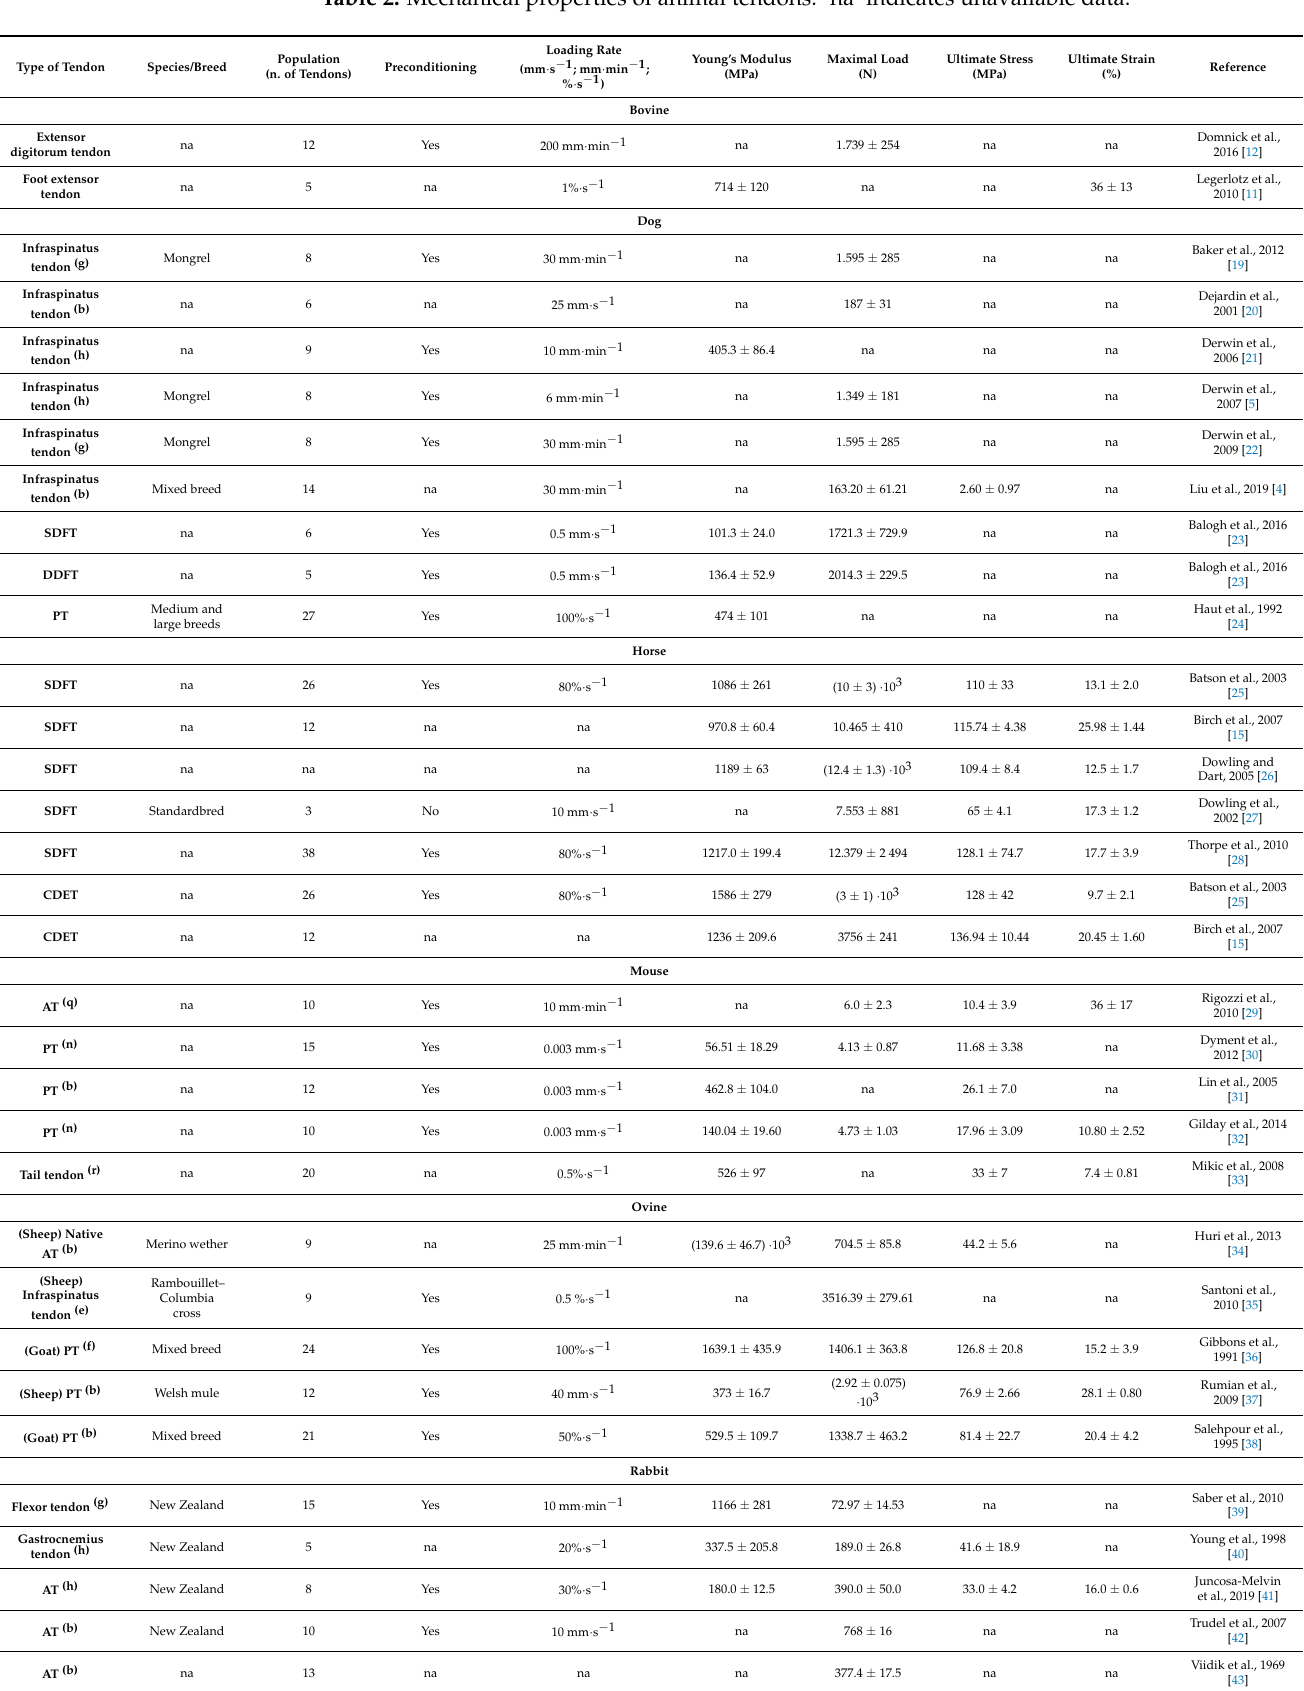
Table 2. Mechanical properties of animal tendons. ‘na’ indicates unavailable